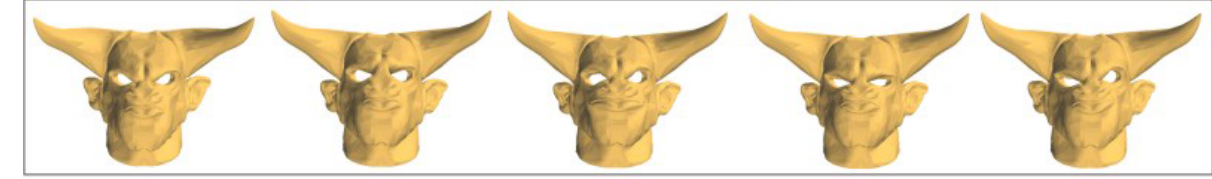
Figure 25. Expressions transferred to a minotaur model.